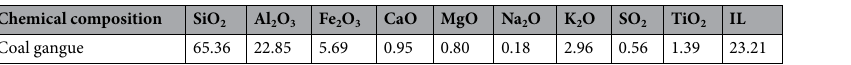
Table 2. Chemical composition of CG (%). The data in the table is obtained by XRD (Ultima IV, Rigaku, Japan).